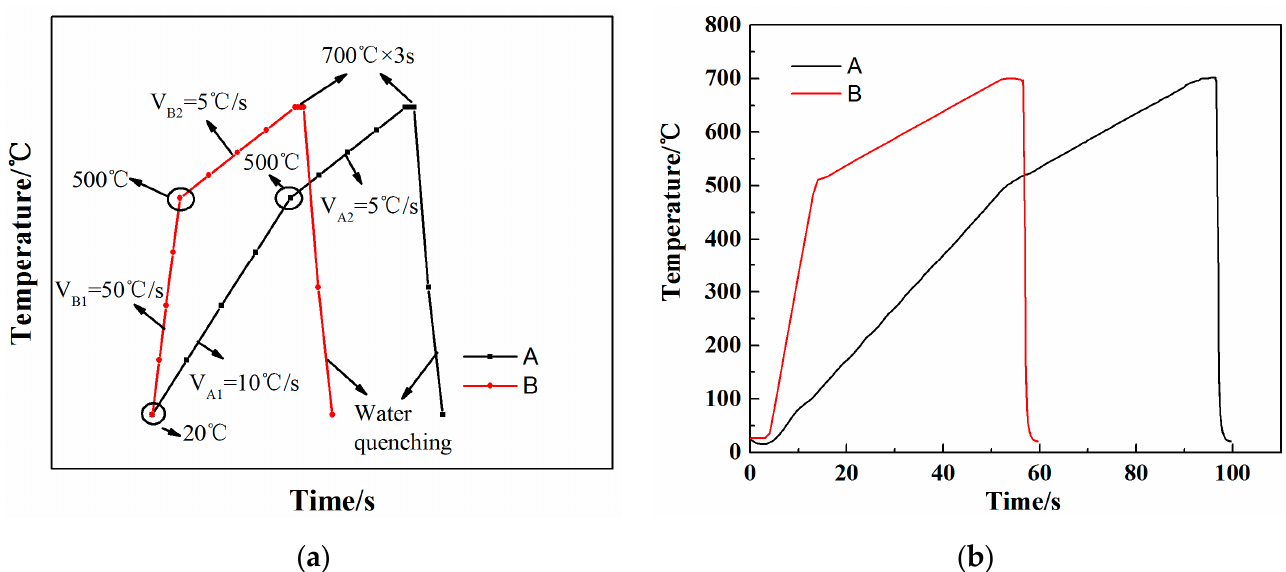
Coatings 2021 , 11 , x FOR PEER REVIEW 6 of 15 Figure 5. Two-step heating methods of ( a ) theoretical thermal history and ( b ) actual thermal history.